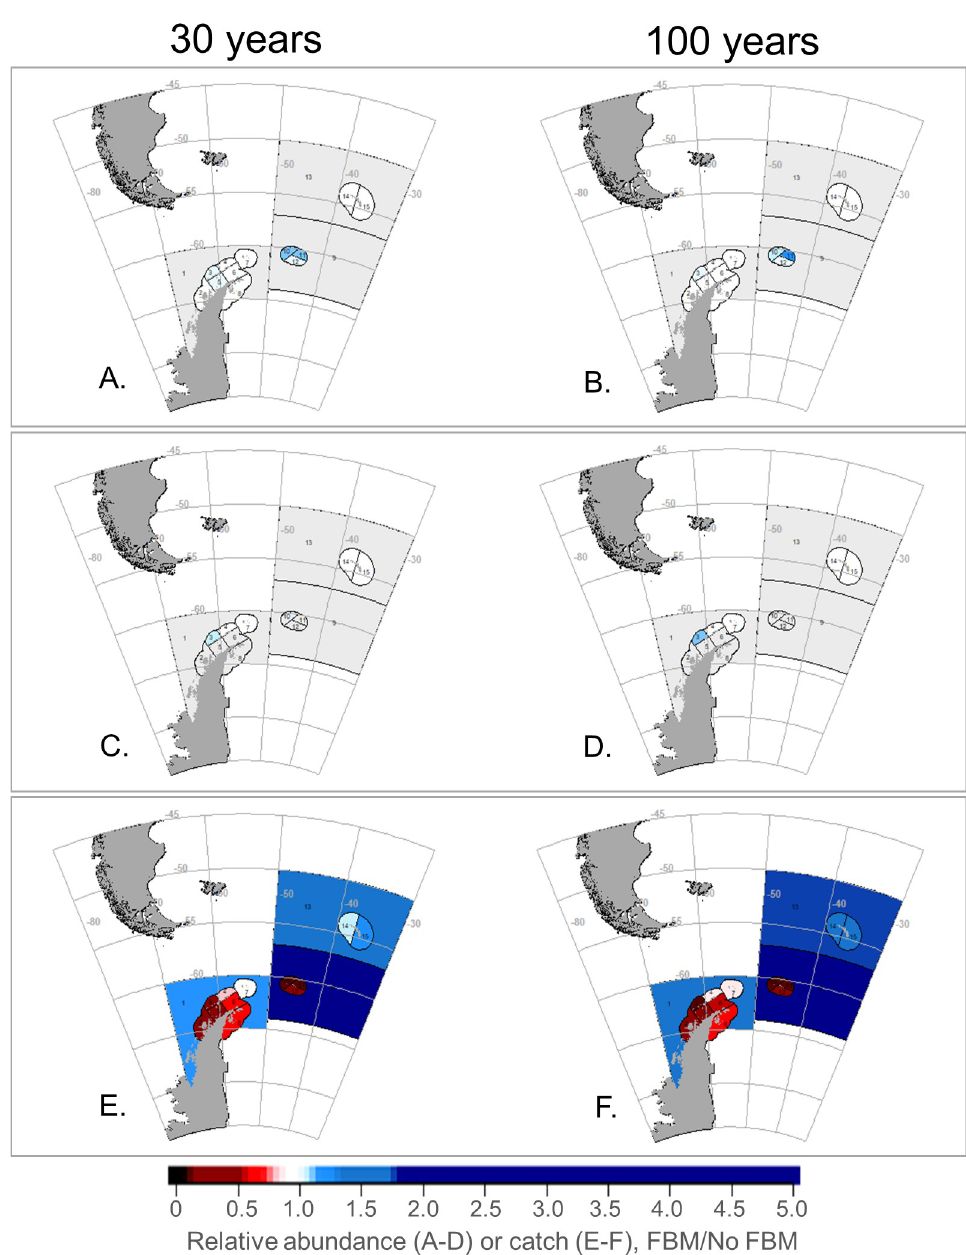
Fig 4. SSMU-specific outcomes of FBM-Krill for predators and the fishery under a modeled climate change impact. Projected penguin (A, B) and seal (C, D) abundances, and krill catches (E, F) given climate-change impacts on krill growth, with outcomes at 30 years in to the model run in the left column (A, C, E) and at 100 years in the right (B, D, F). Blues represent increases relative to the No FBM base case scenario and reds decreases; white and light colors indicate no or little change. Light grey denotes areas where the species group is not modeled as resident. Note changes are relative to the No FBM base case within each SSMU, not over the entire model arena. That is, both FBM-Krill and FBM-Pengs result in more SSMUs with less catch, whereas more SSMUs yield relatively greater catches with the MPA. Second, all SSMUs under either FBM strategy where penguins increased in the model (blue squares and triangles above the y = 1 line) were also in SSMUs with lower catches. In contrast, both catches and penguin